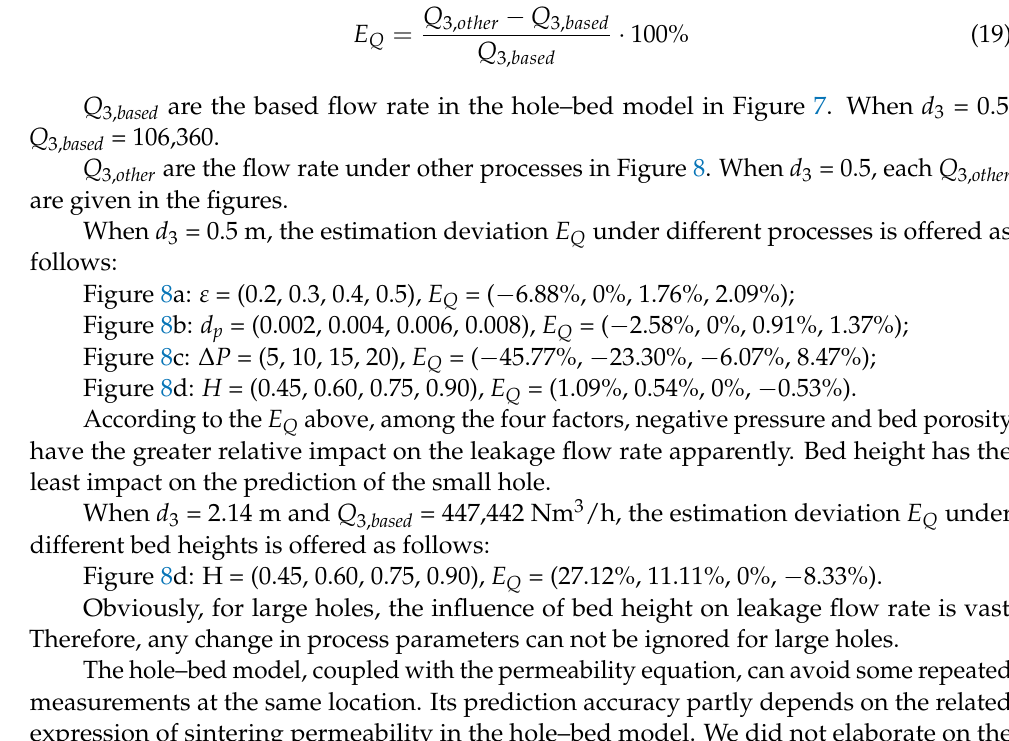
Figure 8d: H = (0.45, 0.60, 0.75, 0.90), E Q = (27.12%, 11.11%, 0%, −